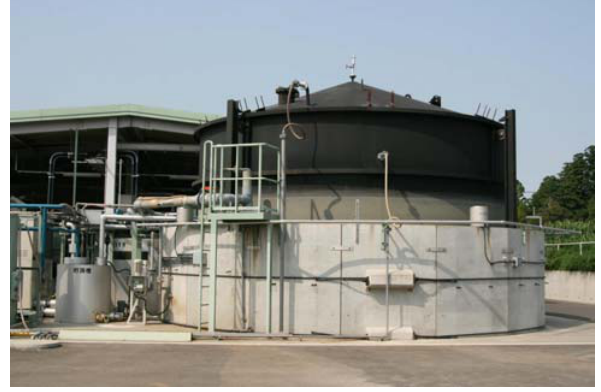
Figure 2. Fermentation tank in the Yamada Biomass Plant.